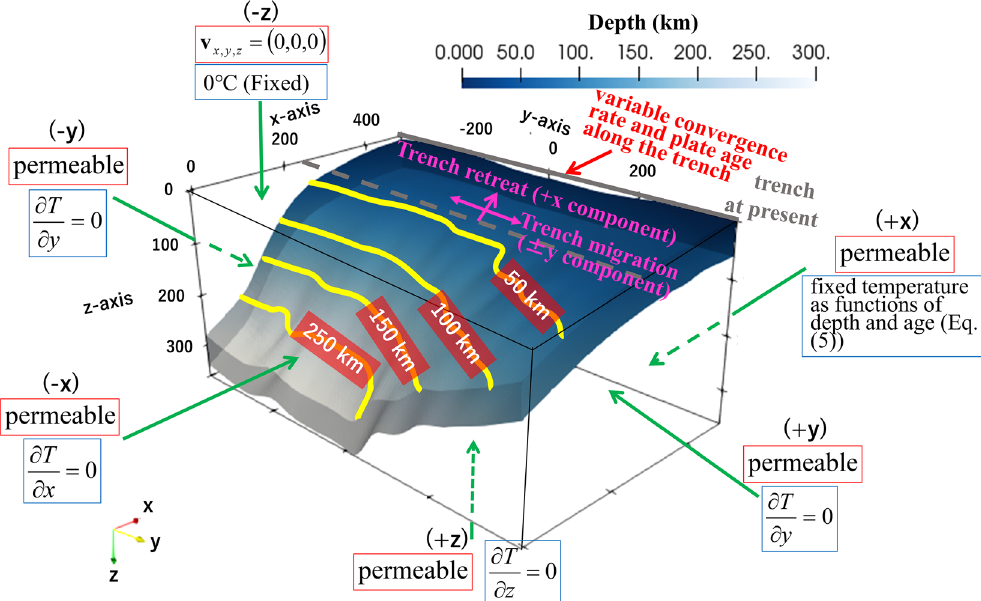
Figure 2. Schematic figure of the 3-D Cartesian thermomechanical subduction model used in this study. The mantle flow and thermal boundary conditions at respective boundaries are noted by red and blue surrounded lines, respectively. The yellow solid lines on the plate interface denote isodepth contours of the subducting PHS